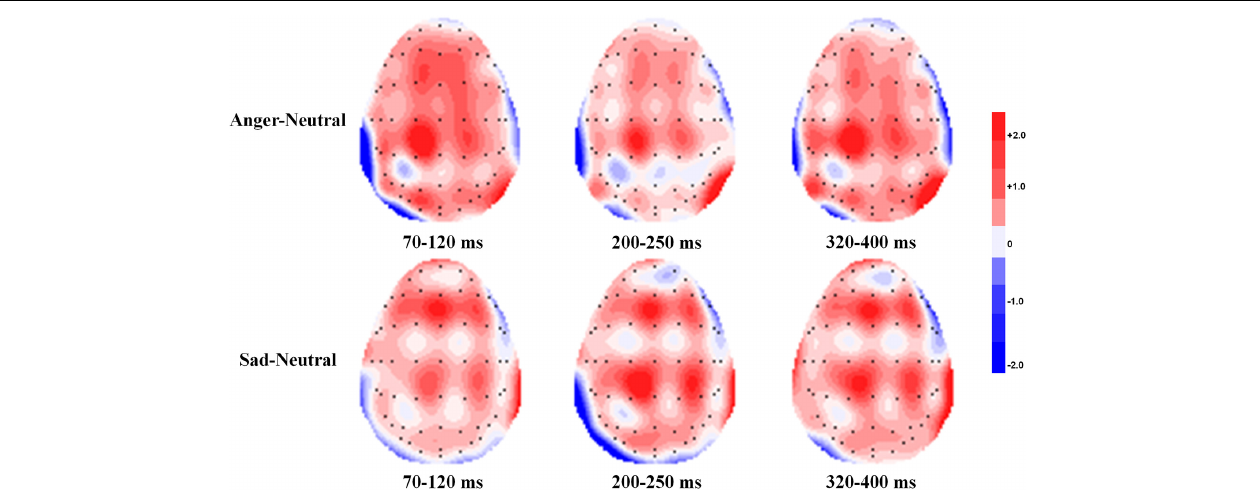
FIGURE 4 | Topographic maps depicting voltage differences for the anger prime condition minus the neutral prime condition and the sad prime condition minus the neutral prime condition in the time range of P1 (70–120 ms), P2 (200–250 ms), and P3 (320–400 ms) during the evaluation